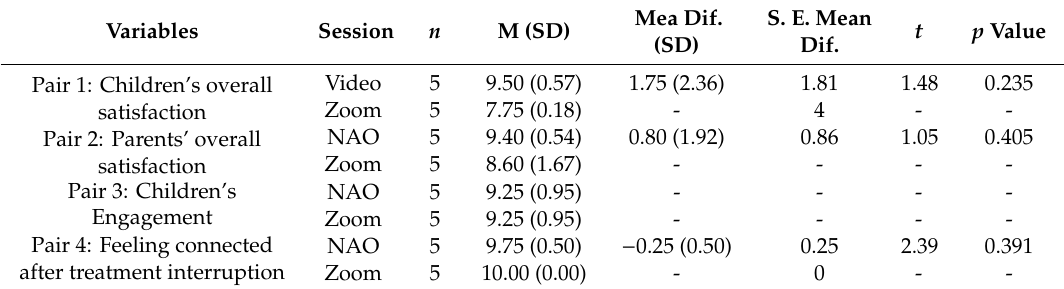
Table 4. Comparison between video and Zoom